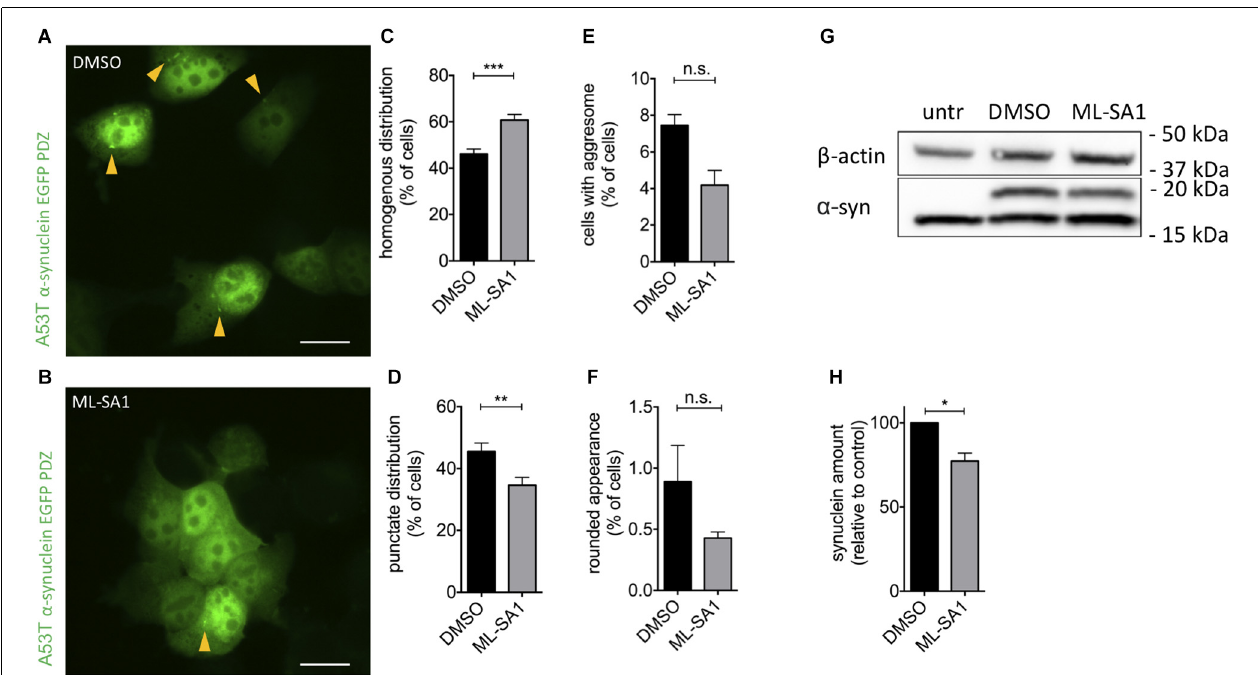
FIGURE 1 | TRPML1-Agonist ML-SA1 reduces α -synuclein aggregates and protein in HEK293T cells. (A,B) Example images of HEK293T cells transfected with GFP-tagged A53T- α -synuclein, and treated with 25 µ M ML-SA1 or DMSO only as a control, starting 6 h after transfection for 18 h. The scale bar represents 20 µ m. (C–F) Quantitative analysis of GFP distribution patterns as in Supplementary Figure 1A in about 100 cells per group and experiment, summary of n = 3 independent experiments. Two-way ANOVA (factors treatment and phenotype) showed a significant interaction ( p < 0.0001). Results from Sidak’s multiple comparisons tests are depicted. (G) Example immunoblot of lysates from HEK293T cells transfected and treated as in (A) . Note that the lower (16 kDa) band is nonspecific since it is present in untransfected cells (Dinter et al., 2016). Full blot shown in Supplementary Figure 1C . (H) Quantification of the synuclein band relative to actin in n = 3 independent experiments as in (G) . Result of unpaired t -test depicted with respect to DMSO ( p = 0.01). * p < 0.05, ** p < 0.01, *** p < 0.001, non-significant differences are depicted as